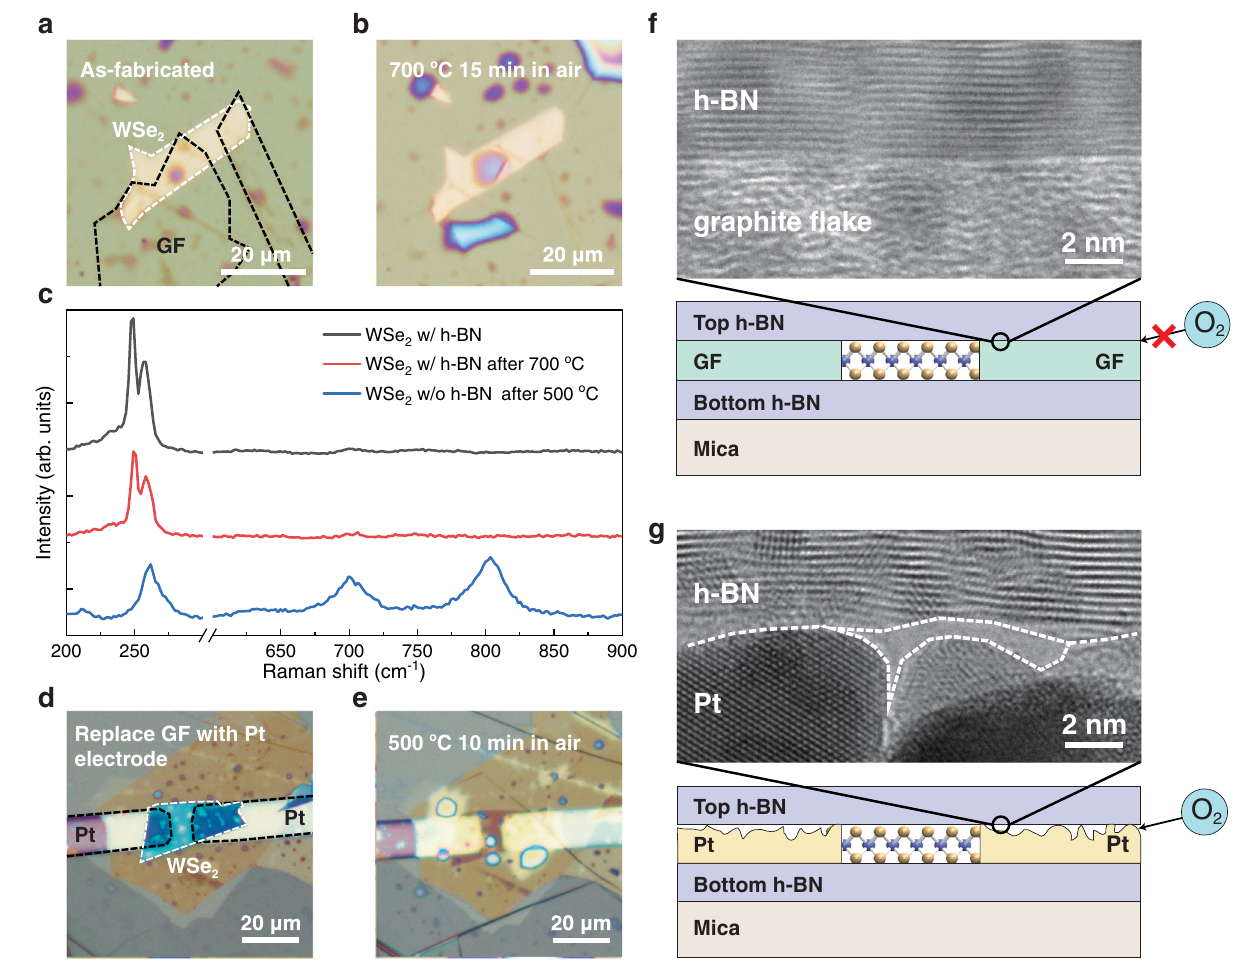
f HRTEM cross-sectional image of h-BN/GF interface and schematical cross- sectional view of WSe 2 FET with GF electrodes. Oxygen cannot diffuse into h-BN encapsulationthroughh-BN/GFinterface. g HRTEMcross-sectionalimage ofh-BN/ Pt interface and schematicalcross-sectionalview of WSe 2 FETwith Pt electrodes. A white dashed line is used to indicate the bottom interface outline of h-BN and top interface outline of Pt electrodes. Oxygen can diffuse into h-BN encapsulation through h-BN/Pt